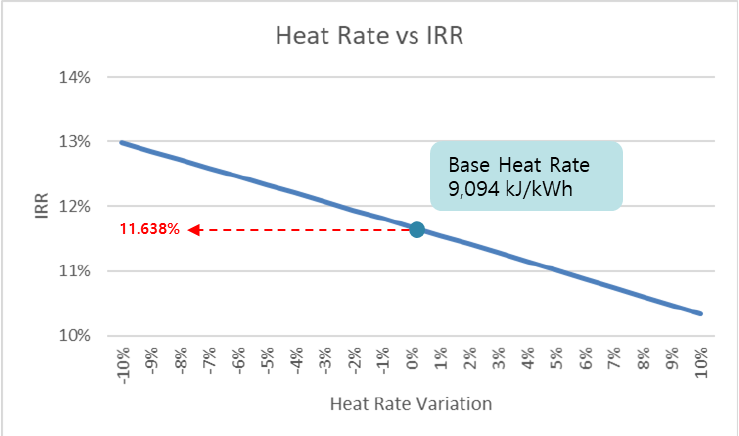
Figure 8. IRR sensitivity due to a heat rate change.